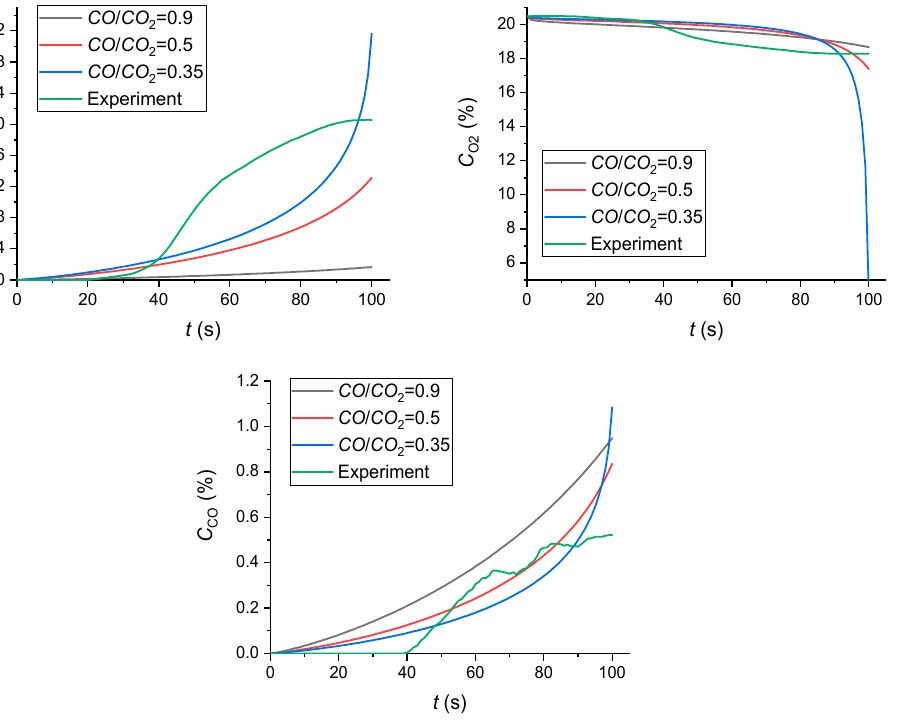
Figure 9. Numerical simulation results (the release of gaseous products of flame combustion and thermal decomposition of wood compared with the results of experimental studies).